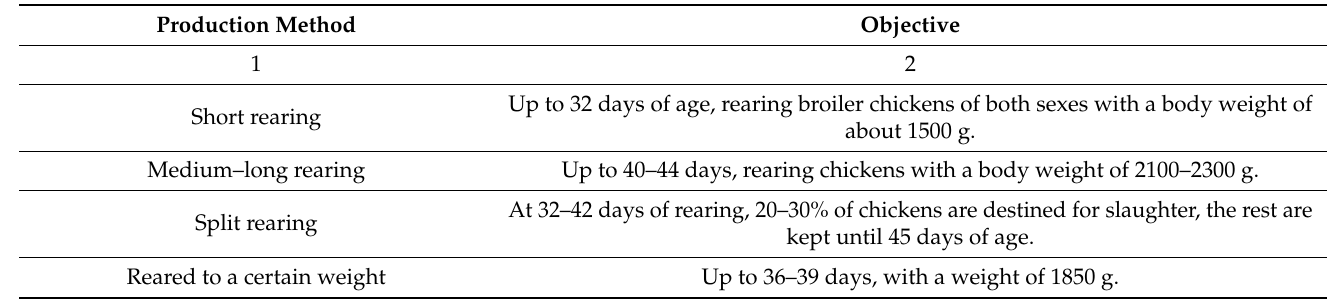
Table 1. Methods of producing meat chickens.